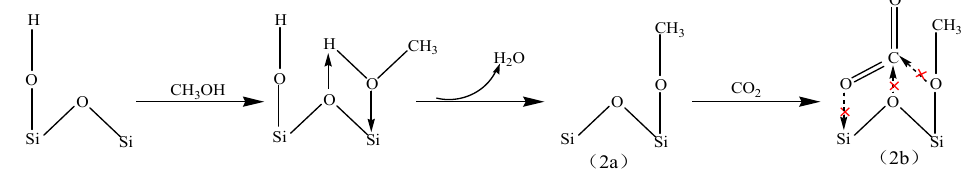
Figure 3. In situ FTIR spectra of CO 2 adsorption on Zr/SBA-15 pre-adsorbed CH 3 OH in the regions of 3600 cm − 1 –3800 cm − 1 ( A ), in situ FTIR spectra of CO 2 adsorption on Zr/SBA-15 pre-adsorbed CH 3 OH in the regions of 2700 cm − 1 –3100 cm − 1 ( B ), in situ FTIR spectra of CO 2 adsorption on Zr/SBA-15 pre-adsorbed CH 3 OH in the regions of 1500 cm − 1 –1700 cm − 1 ( C ), in situ FTIR spectra of CO 2 adsorption on Zr/SBA-15 pre-adsorbed CH 3 OH in the regions of 1300 cm − 1 –1500 cm − 1 ( D ). Based on the above process, there may be four synthetic routes for the m-CH 3 OC(O)O-Zr(Si) on the Zr/SBA-15 catalyst, as suggested in Schemes 1–4.